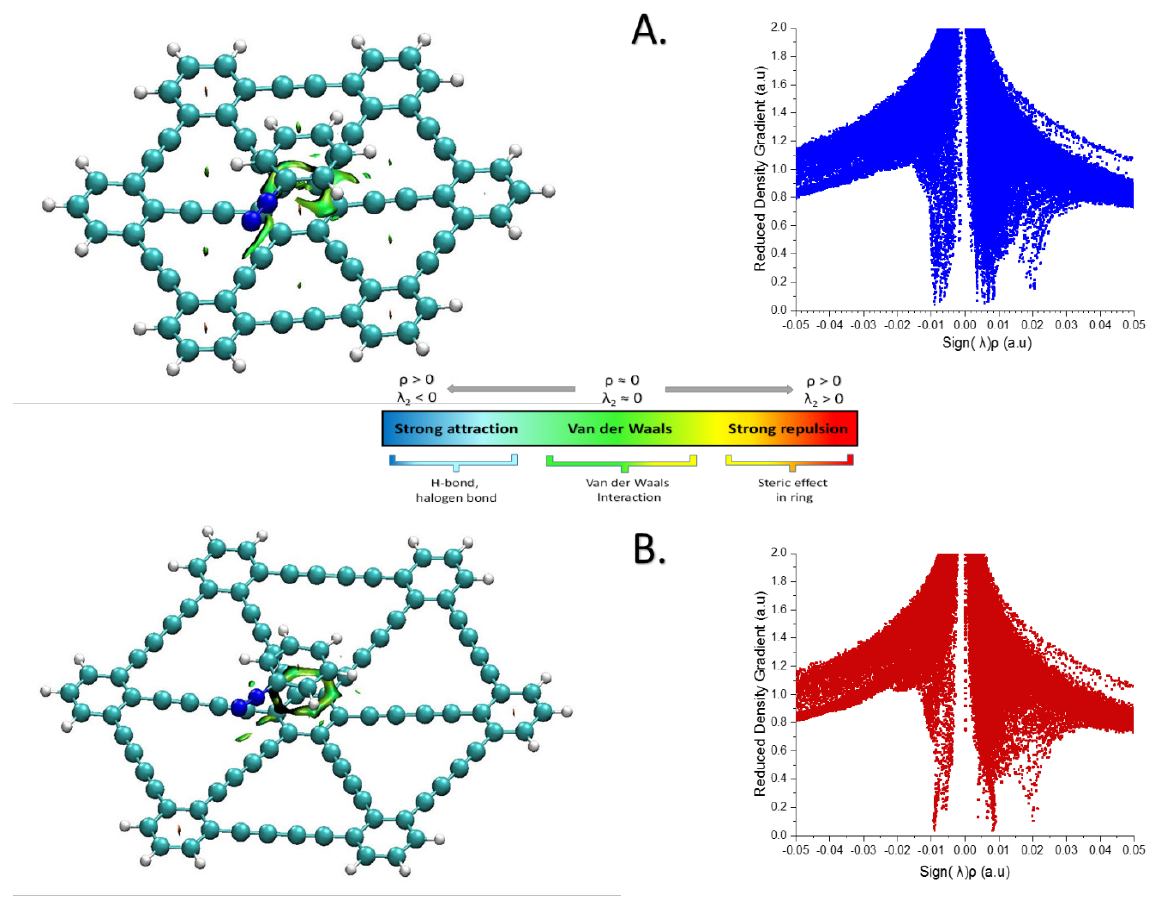
Figure 4: Non-covalent interaction surfaces and the plot of Reduced Density Gradient (RDG) vs. sign(λ)ρ for the interaction of A. Graphyne/ Ph-N 2+ and Graphdiyne/ Ph-N 2+